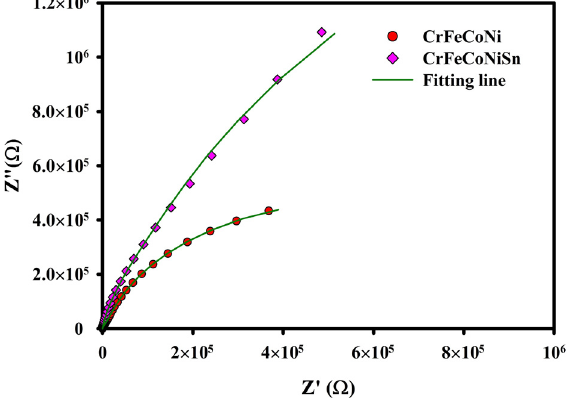
Figure 6. The Nyquist plots of CrFeCoNi and CrFeCoNiSn alloys in 0.6 M NaCl solution at ambi- ent temperature.